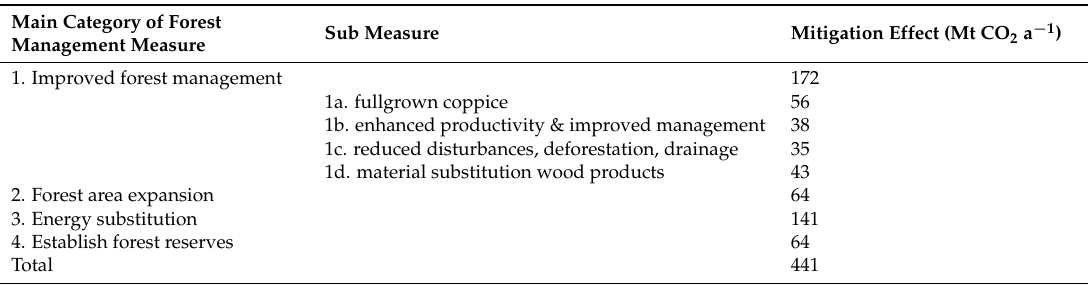
Table 1. Summation of the Climate Smart Forestry mitigation effect. All numbers are